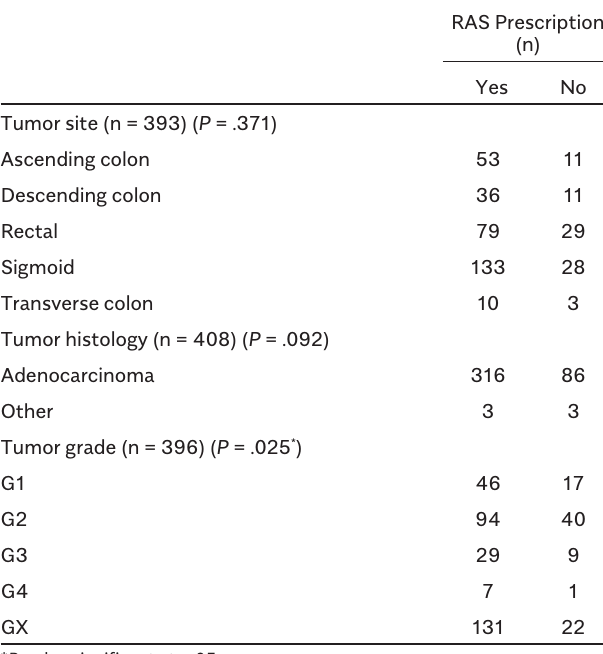
RAS Prescription (n) Yes No